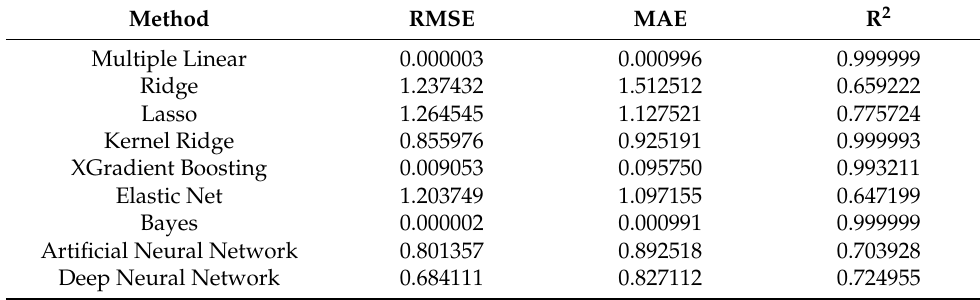
Table 5. Error metric values for power prediction (primary findings).